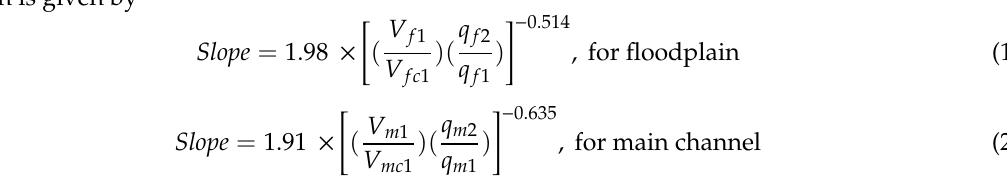
)( q ) for ( a ) in 2 / q 1 1 / V C 1